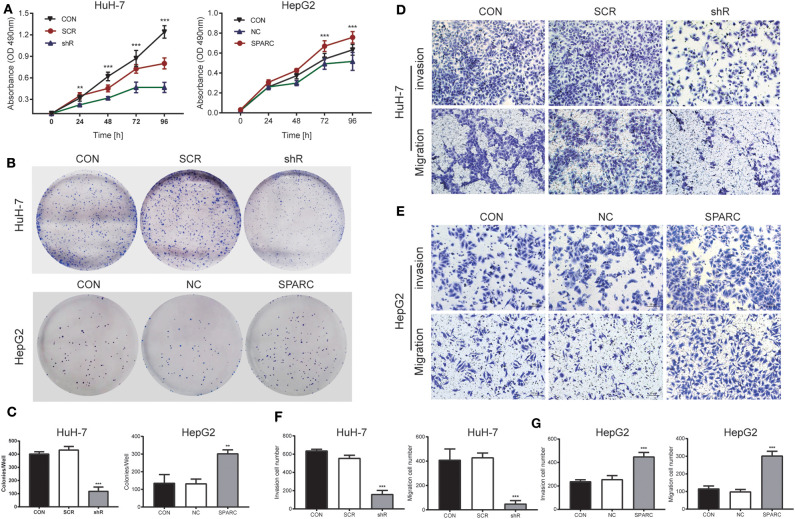
Knockdown of SPARC suppresses the proliferation, migration and invasion of HuH-7 cells, whereas upregulation of SPARC promotes those processes in HepG2 cells. (A) As shown by the MTT assay, 24 h of knockdown led to an obvious arrest of cells, whereas 72 h of upregulation greatly enhanced the proliferation of cells. (B,C) The plate colony formation assay facilitated the characterization of the ability of cells for colony formation. Assays on the migration and invasion of cells were conducted using shR or SCR-infected HuH-7 cells (D,F), as well as SPARC or NC-infected HepG2 cells (E,G). There was no significant difference of proliferation, migration and invasion between CON cells and SCR or NC cells. **p < 0.01, and ***p < 0.001. CON, untreated HuH-7 or HepG2 cell lines; SCR, scramble-sequence; NC, negative control; shR, SPARC-shRNA; SPARC, SPARC-infected.